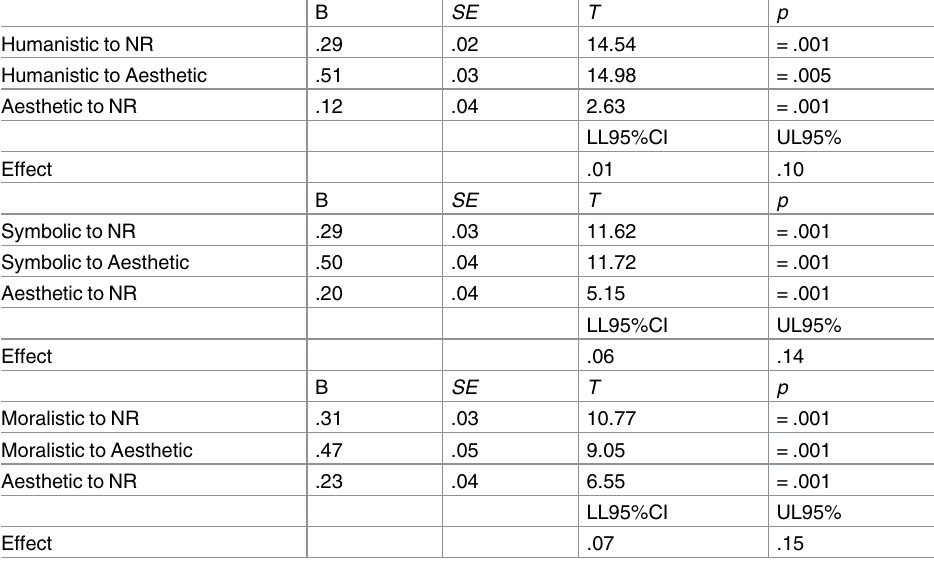
Table 6. Simple mediation of the indirect effectsof engaging with humanistic, moralistic and sym- bolic values on nature connectedness (N = 203; 5000 bootstrap samples). B SE T